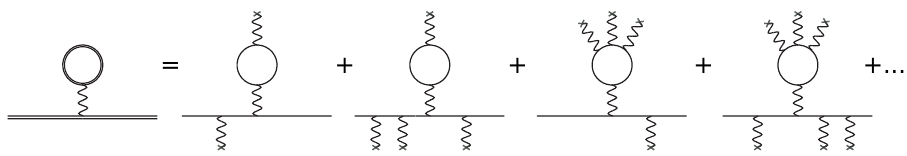
Figure 8 . The weak (cid:12)eld expansion of the reducible contribution to the scalar self-energy. A single photon attached to the loop can be renormalised away. Only an odd number of low energy photons couple to the line in Fock-Schwinger